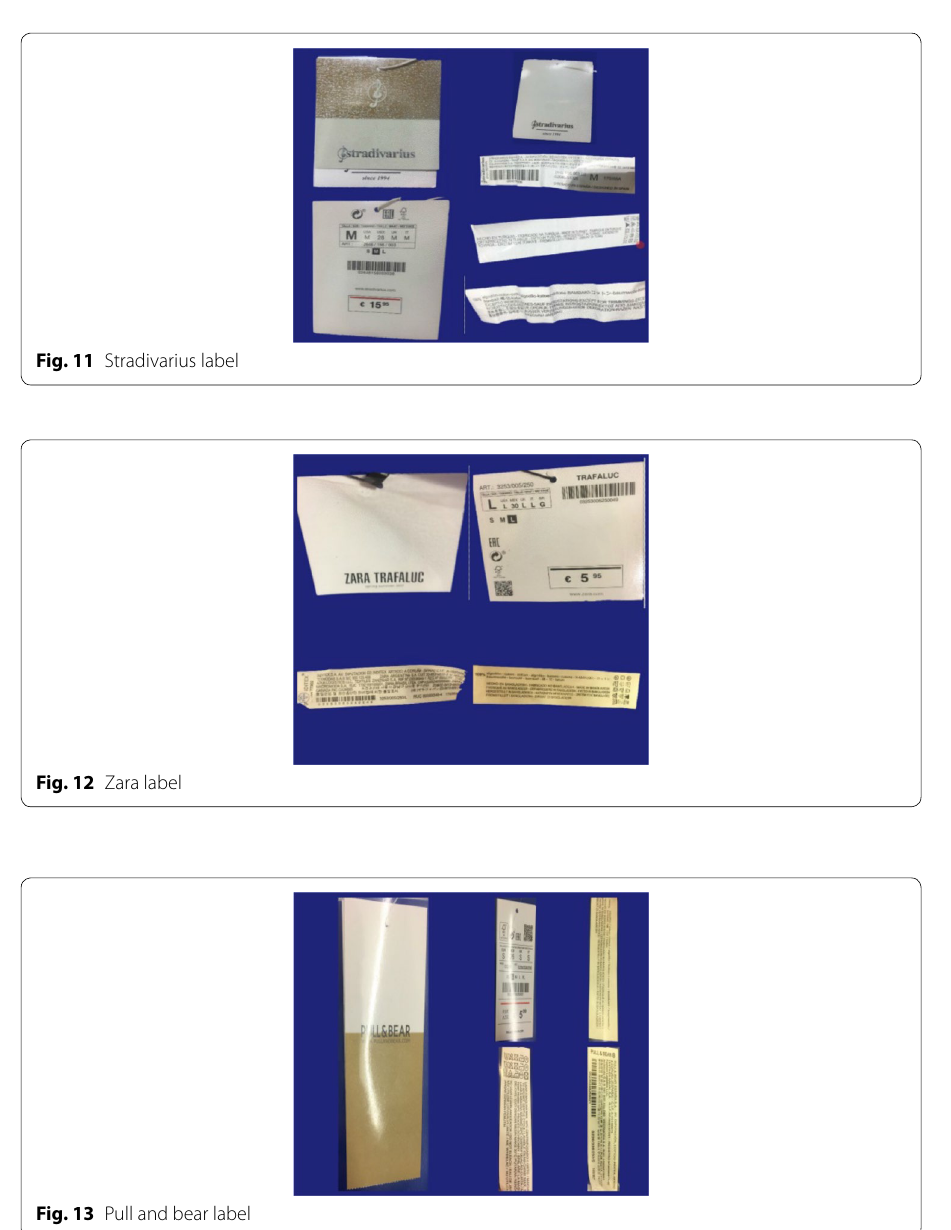
Fig. 13 Pull and bear